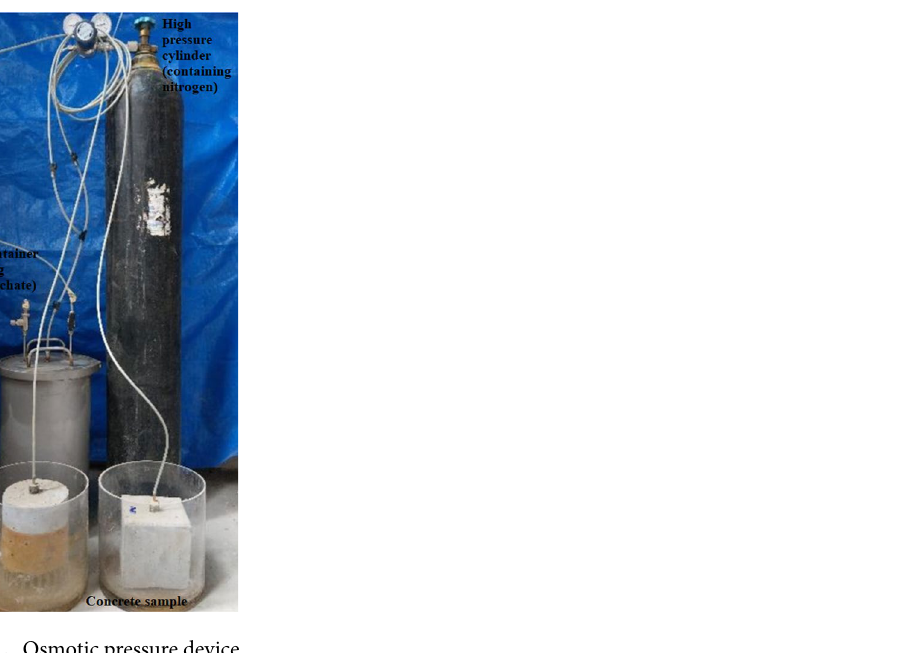
Figure 1. Osmotic pressure